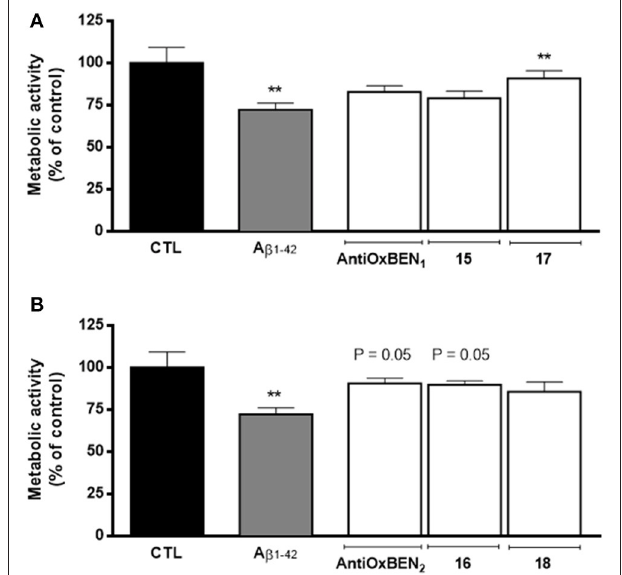
FIGURE 3 | Neuroprotective effects of compounds (A) AntiOxBEN 1 , 15 and 17 and (B) AntiOxBEN 2 , 16 and 18 in human neuroblastoma SH-SY5Y cells against A β 1–42 peptide-induced cytotoxicity measured by changes in cellular metabolic activity. Cells were pre-treated with mitochondriotropic antioxidants (10 µ M) for 24h before treatment with A β 1–42 peptide (25 µ M) for 48h more. The comparisons were performed by using one-way ANOVA between the control (A β 1–42 peptide) vs. preparation where antioxidants AntiOxBEN 1 , AntiOxBEN 2 and 15 – 18 were pre-incubated. Data are means ± SEM of three independent experiments and the results are expressed as percentage of control (control = 100 %), which represents the cell density without any treatment in the respective time point. Significance was accepted with ** P < 0.01 vs.